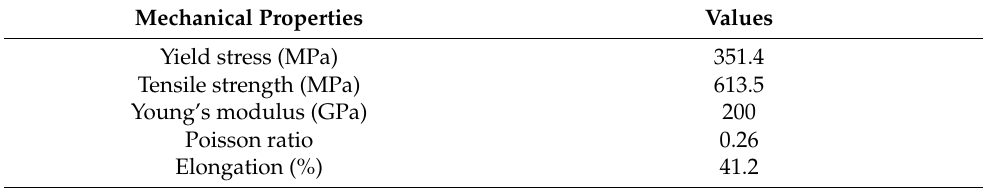
Table 1. Mechanical properties of the workpiece.